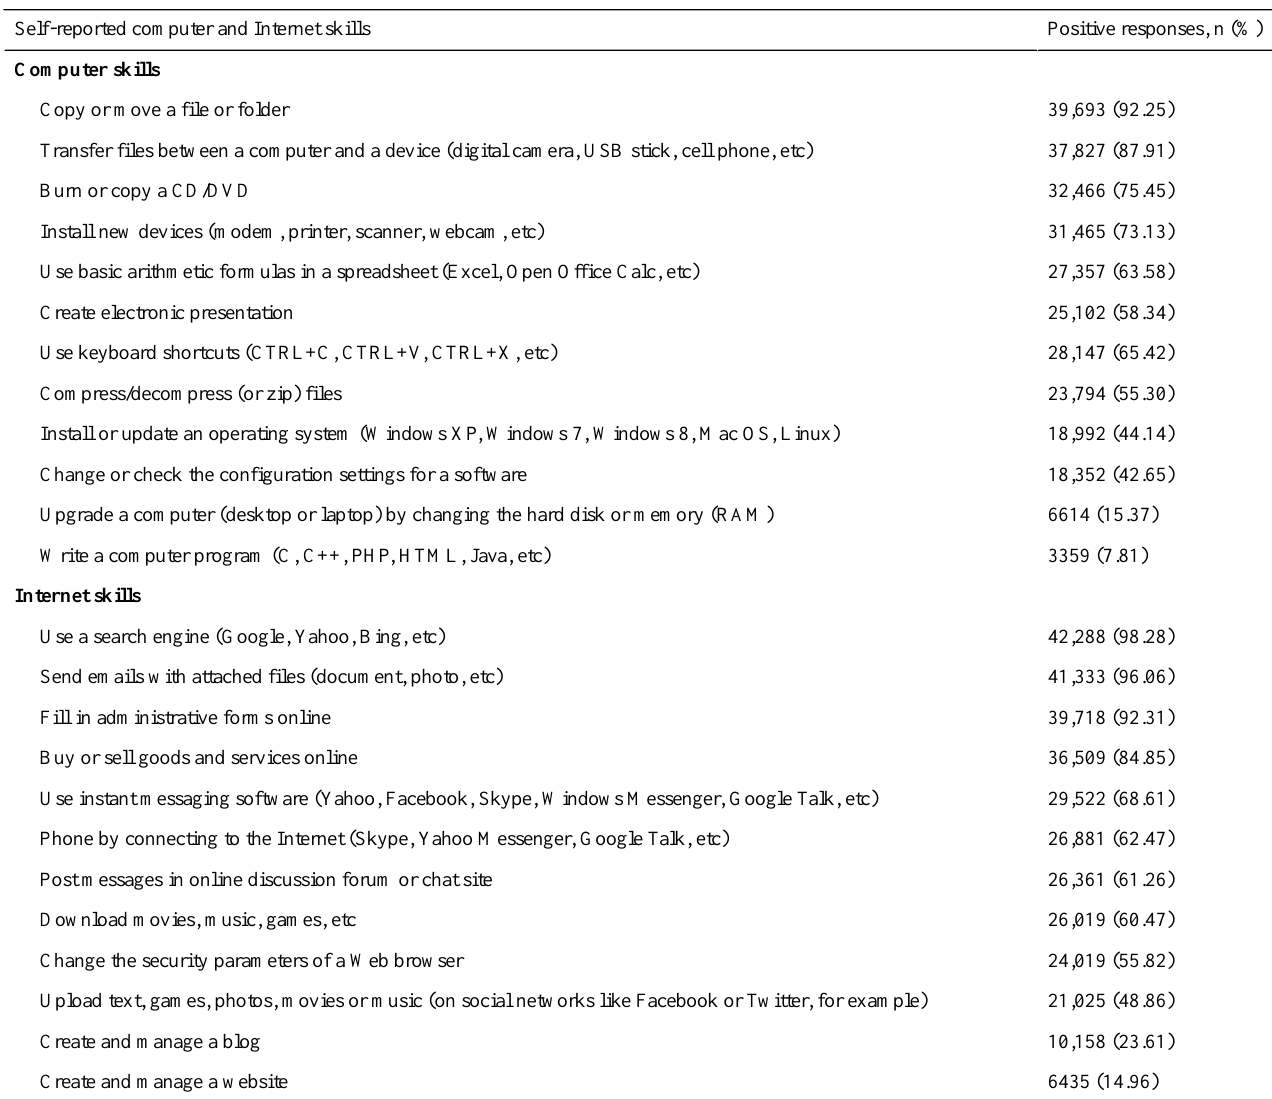
Table 2. Self-reported computer and Internet skills of participants (n=43,028), NutriNet-Santé Study, France,